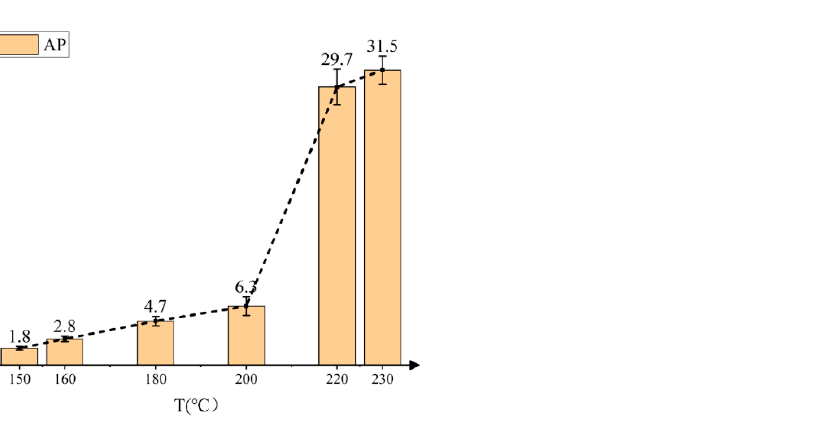
Figure 4. The mass-loss rate of AP with temperature.